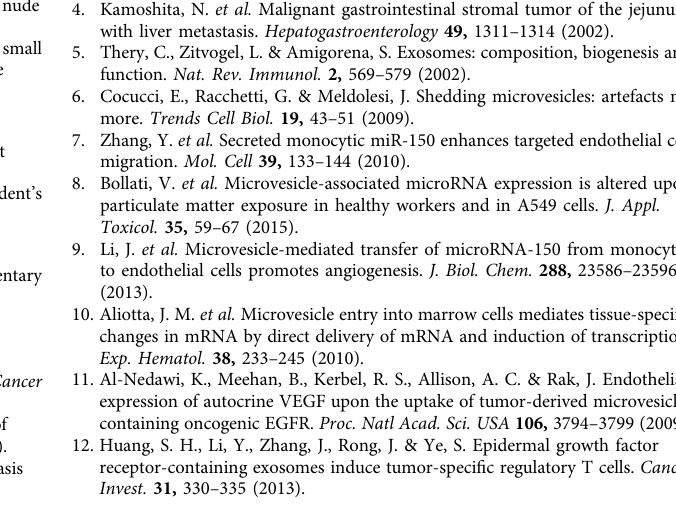
Establishment of tumour in nude mice . SGC7901 cells were injected into nude mice by orthotopic implantation 45 . Briefly, 1 (cid:2) 10 7 cells were first injected subcutaneously for one mouse and tumours were removed and divided into small pieces on the 15th day, each with 0.3g, and the divided small tumours were implanted into the gastric subserosal haematoma.